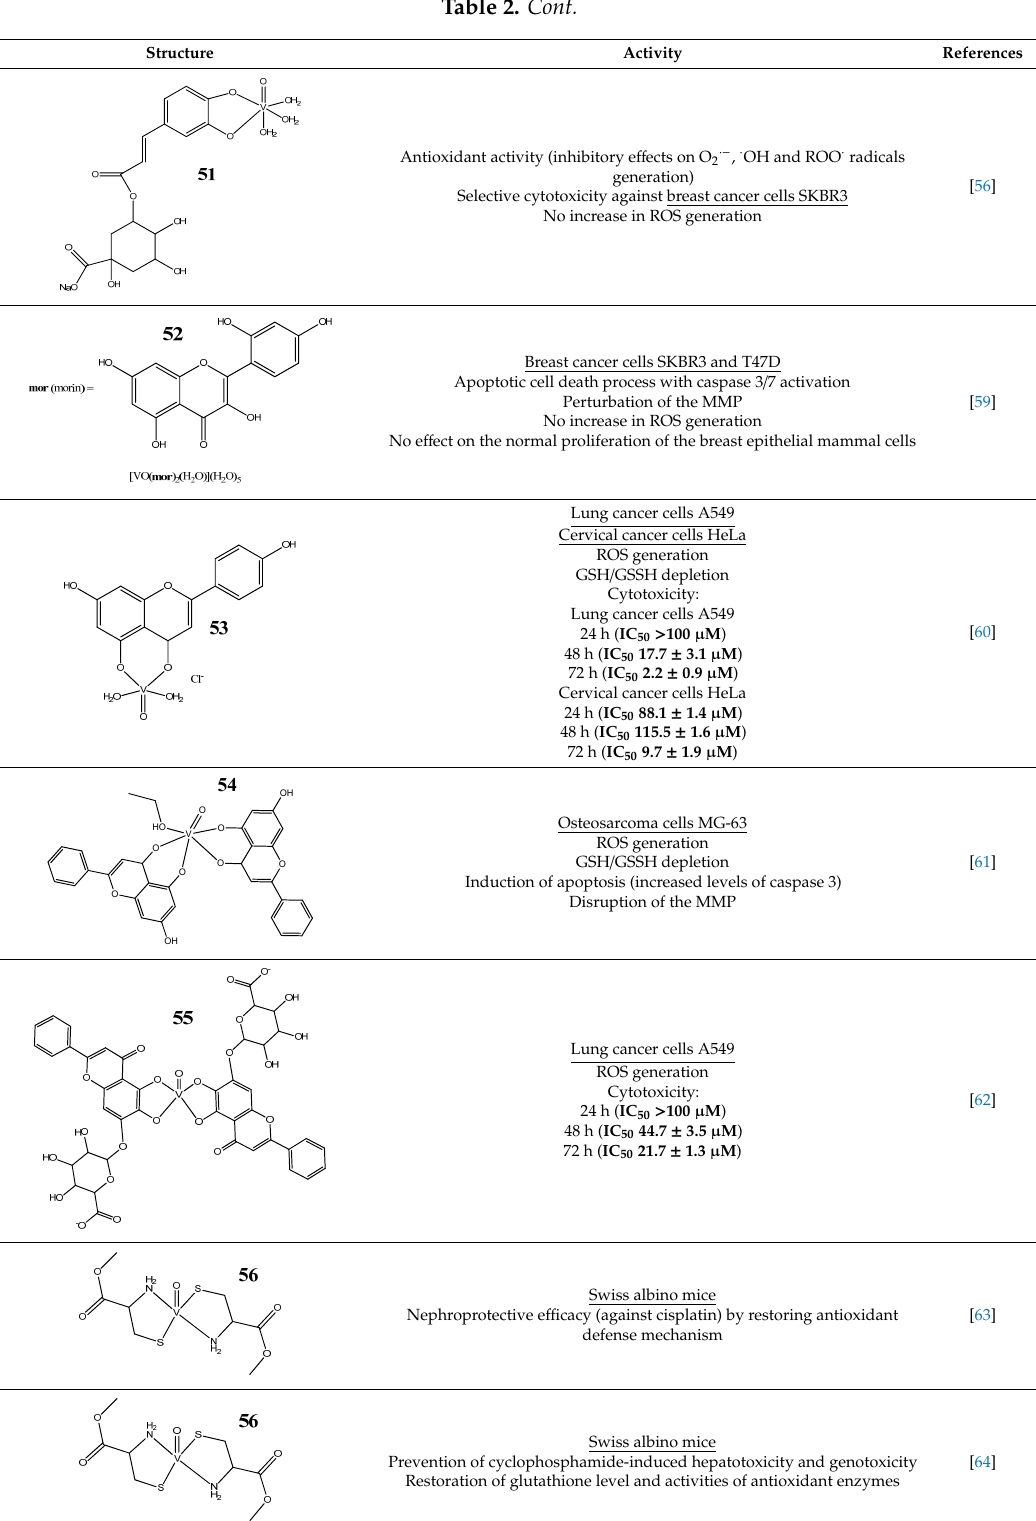
Restoration of glutathione level and activities of antioxidant enzymes Cervical cancer cells HeLa Breast cancer cells MCF-7 ROS generation Photocleavage of plasmid DNA in green light (568 nm) forming · OH